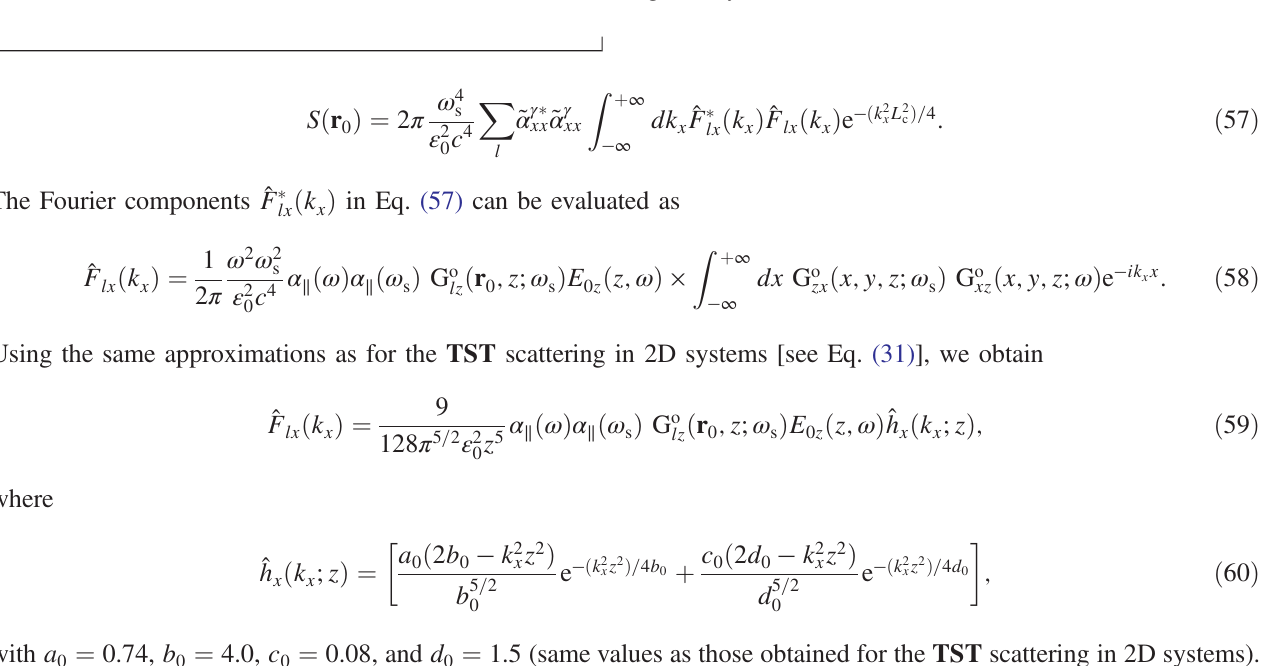
FIG. 8. Distance dependence of the ST signal for the G and G 0 bands. Panels (a-d) account for different values of the correlation : 0, 15, 30, and 45 nm, respectively, as indicated in the length L c ~ f 3 and r 15 nm. The graphics. In all cases, we used e ¼ tip ¼ 20 nm. Compared to signal S ð r 0 Þ is normalized to 1 at z min ¼ the TST signal shown in Fig. 5, the ST signal presents a weaker decay and therefore contributes to the measured signal only for larger tip-sample